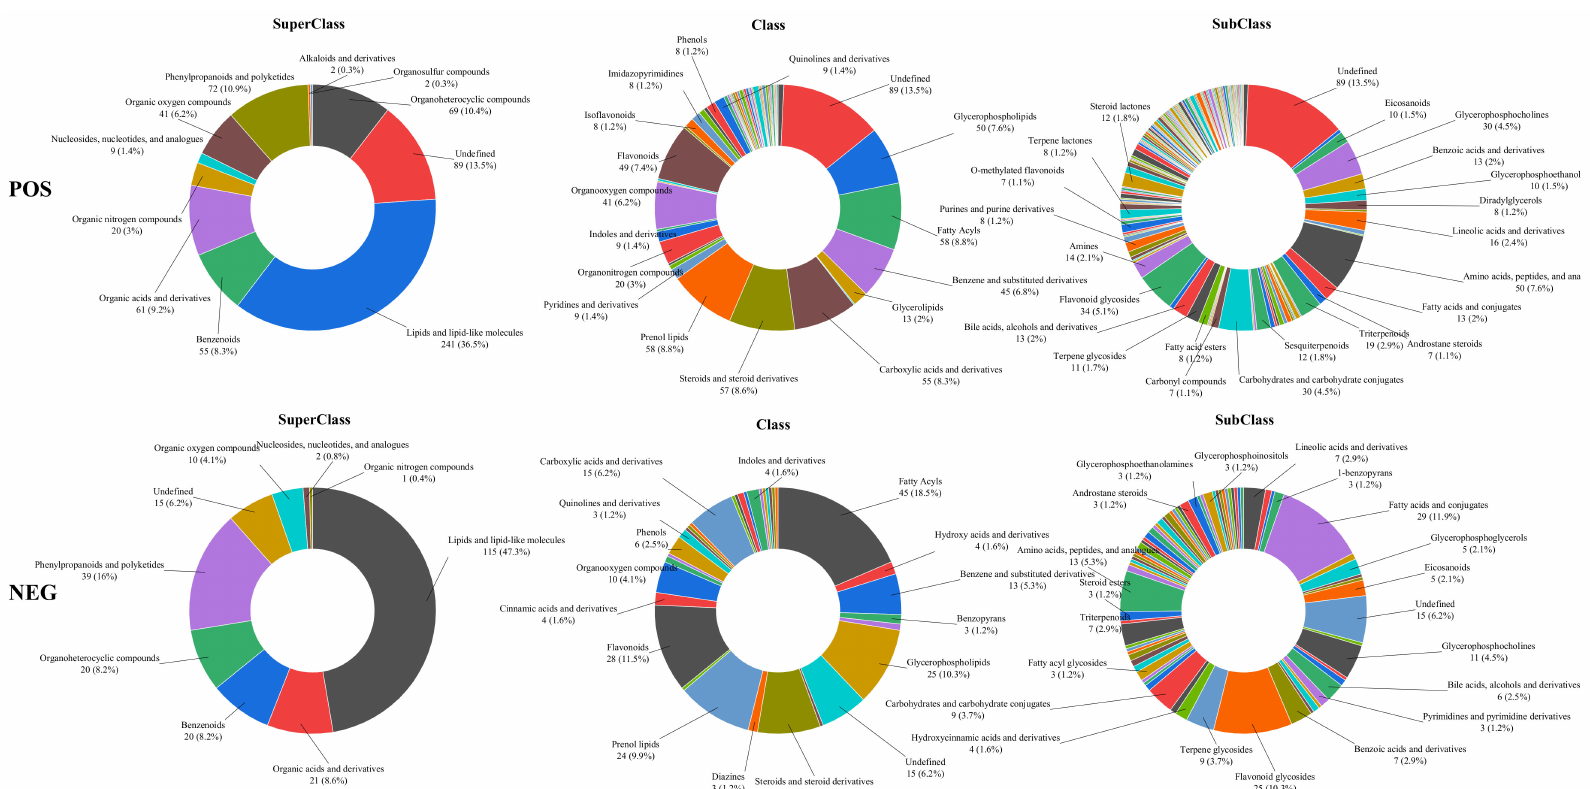
Figure 8. The schematic diagram of the different classifications of the metabolites of EAF fraction of crude extract from